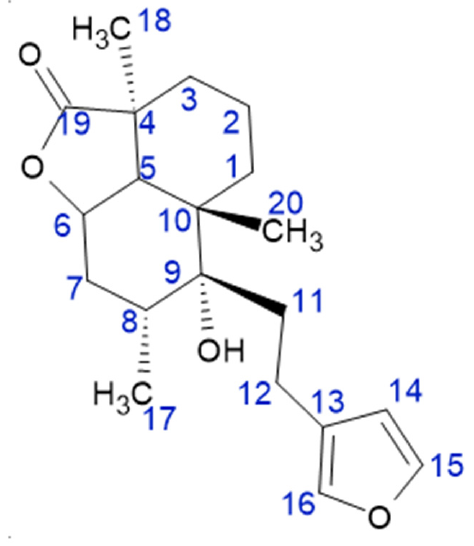
Figure 1. Chemical structure of marrubiin.